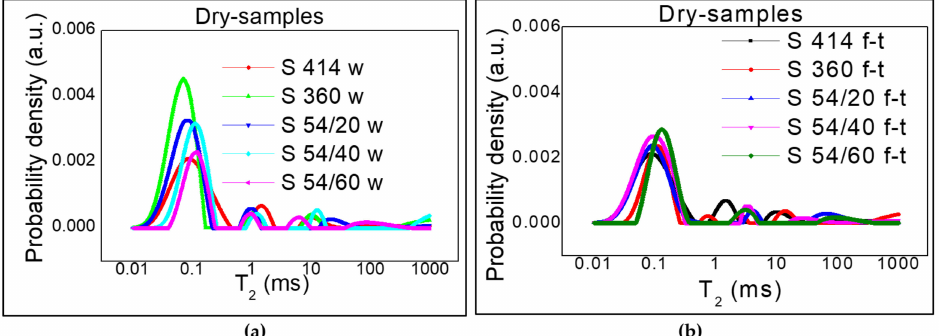
Figure 4. Distribution of the transverse relaxation time T 2 after drying: ( a ) control samples kept in